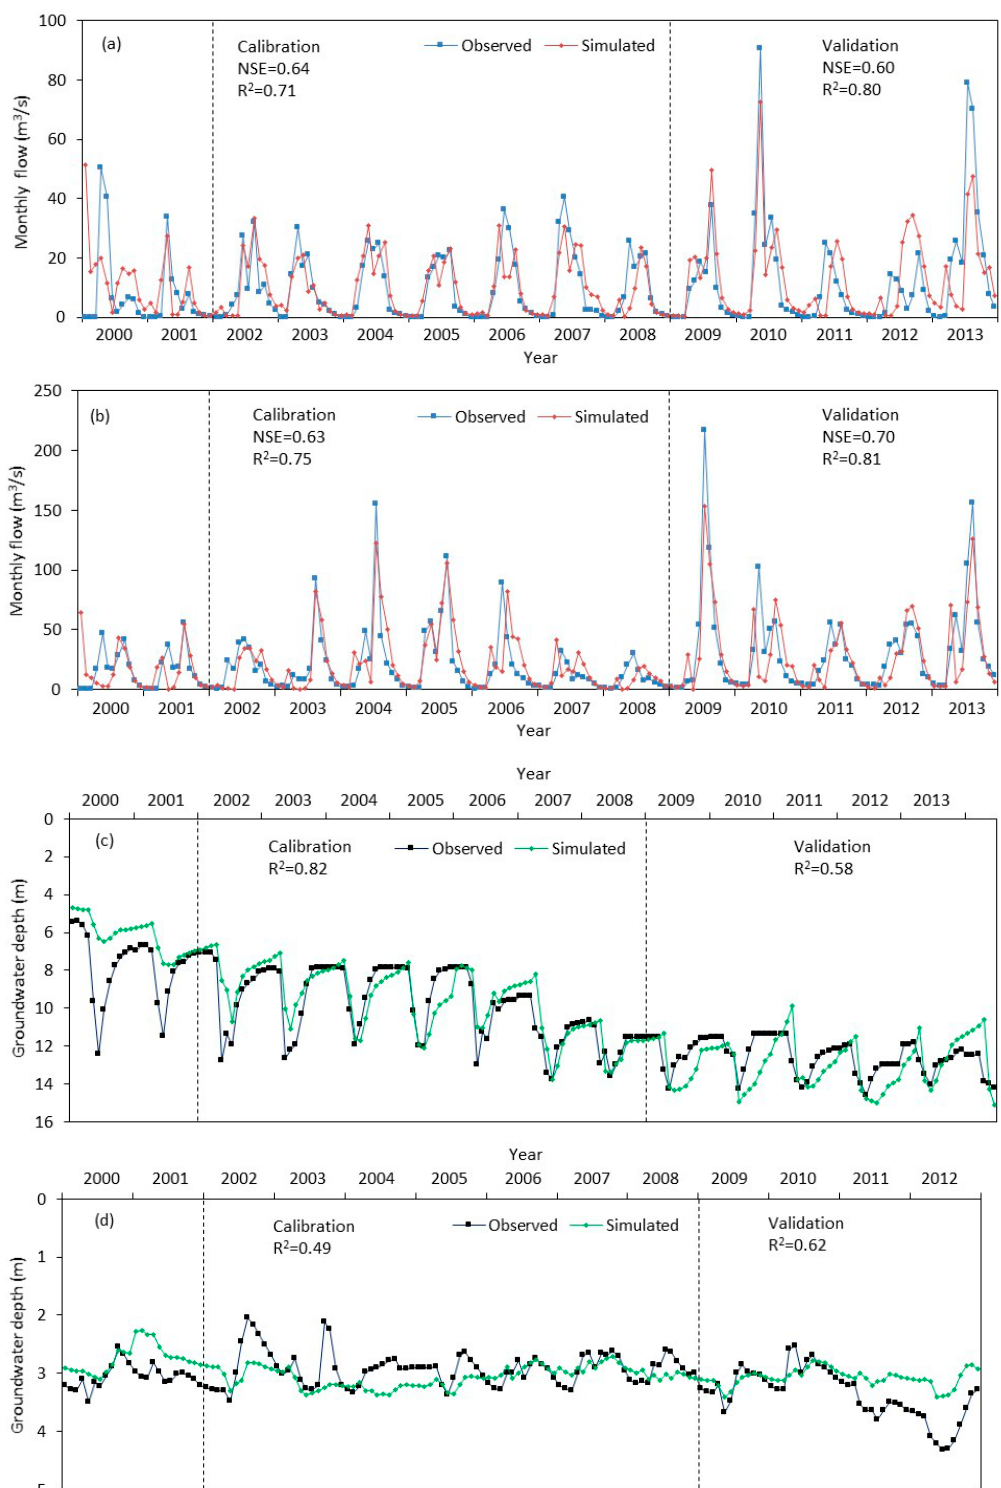
Figure 6. Calibration and validation of monthly flow and groundwater depth at representative hydrologic stations and observation wells in the dynamic land use mode. The years 2000 and 2001 are the warm-up periods of the model. Observations and simulation results are compared at ( a ) the Baoqing Station on the Naoli River, a tributary of the Wusuli River, and ( b ) the Baoquanling Station on the Wutong River, a tributary of the Songhua River, as well as representative observation wells located in ( c ) the Sanjiang Low Plain and ( d ) the Xingkaihu Plain.